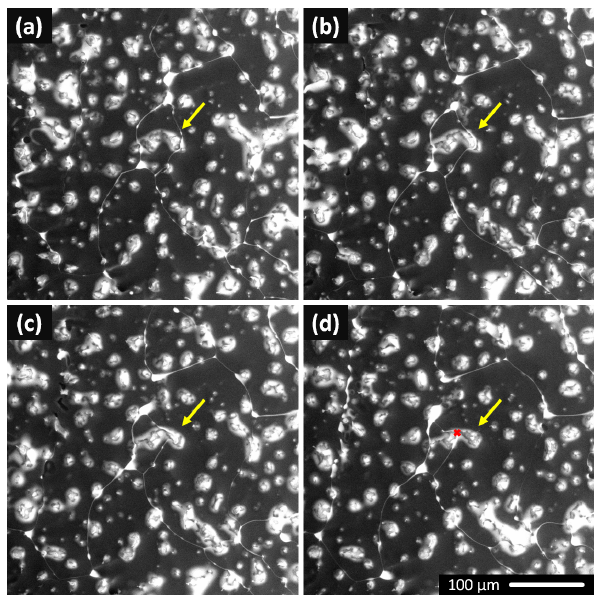
Figure 6. The ice surface dynamics observed at − 23 . 4 ◦ C and 500Pa. The brine-filled grain boundaries (white channels) shifted their positions over time, while the positions of the humps did not change. An example is indicated by the yellow arrow pointing to a CsCl-filled channel moving through a hump. The arrow indicates the initial position of the brine channel in all of the figures. The sample was prepared from the 0.005MCsCl solution by freezing a droplet seeded with ice at − 2 ◦ C. The distance between the brine channel (red point) and the arrow tip (where the movement started) is 31µm; the channel moved by ∼ 19µmmin − 1 . The time interval between the images is approximately 30s. The scale in (d) is valid for all of the